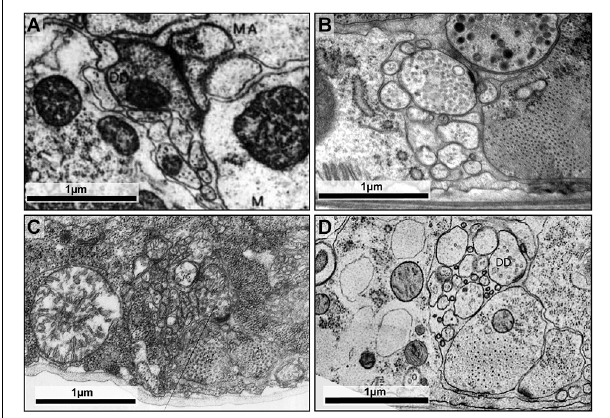
FIGURE 2 | High-pressure freezing improves preservation of ultrastructure. (A) The dorsal cord of an adult prepared using the slow chemical fixation protocol (White et al., 1978). The DD motor neuron is making a neuromuscular junction to dorsal muscle cells. (B) The dorsal cord of an adult fixed using high-pressure freezing and imaged using TEM. The DD motor neuron is making a neuromuscular junction to dorsal muscle cells. (C) The ventral nerve cord of a chemically fixed first stage (L1) C. elegans larva (White et al., 1978). The DD axon makes a NMJ to the ventral muscle cell (M). (D) A TEM micrograph of the ventral nerve cord of a high-pressure frozen first stage larva (L1) at similar region, where DD makes a NMJ to the ventral muscle cell. The advent of high-pressure freezing allows better preserved neurite morphology, synapse structure, and extracellular space, facilitating connectomic and topological analyses of the C. elegans nervous system. Scale bar 1 µ m. Panel (A) was reprinted with permission from White et al. (1978). Panel (C) a scan of the micrograph used in White et al. (1978), hosted by the WormImage Consortium